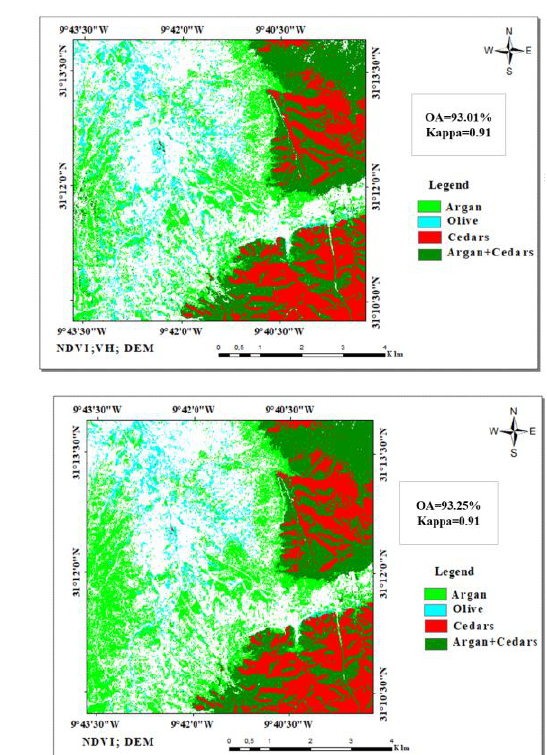
Figure 6 . Maps of spatial distribution of the Argan tree using (NDVI; VH; DEM) and (NDVI;